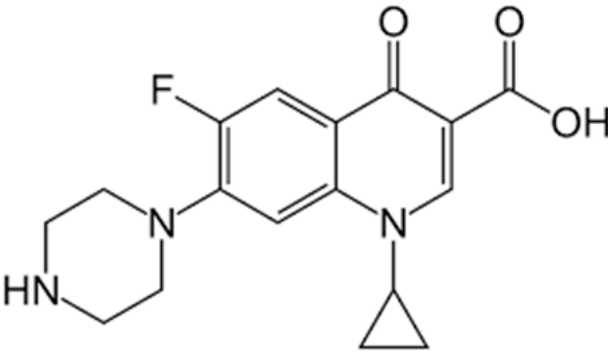
Figure 1. Chemical structure of ciprofloxacin (C 7 H 18 FN 3 O 3 ).